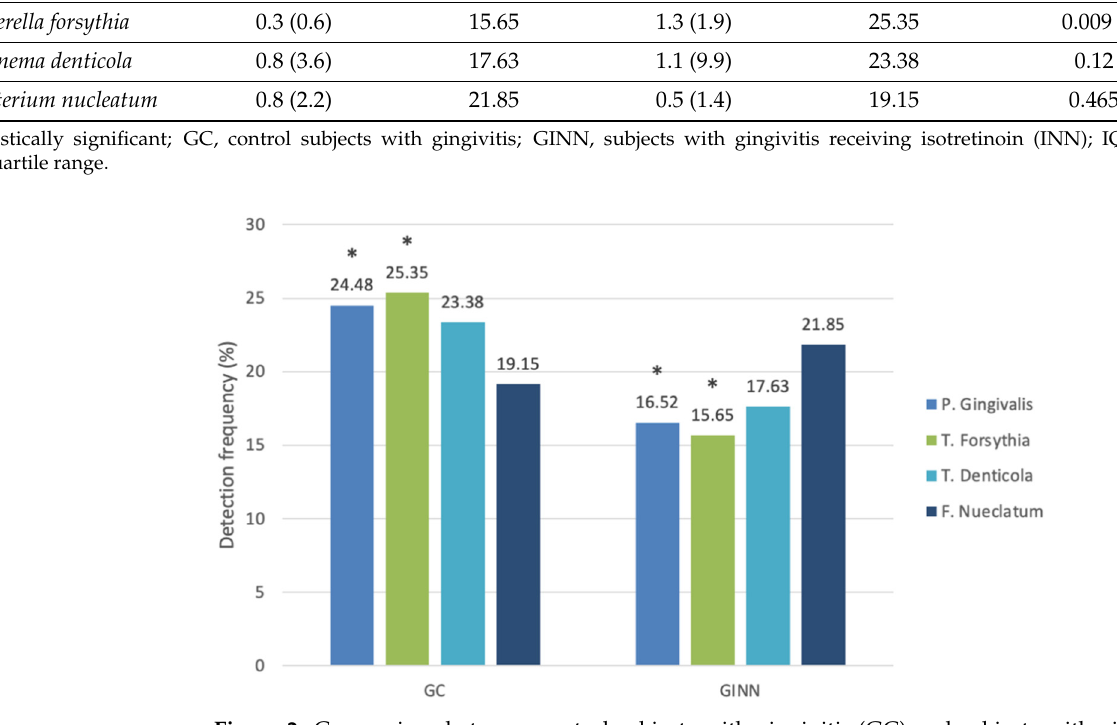
Figure 2. Comparison between control subjects with gingivitis (GC) and subjects with gingivitis receiving isotretinoin (INN) (GINN) in the detection of bacterial pathogens. *, statistically significant. P. gingivalis and T. forsythia levels were significantly higher in the PC group (29.68% and 29.45%, respectively) than in the PINN group. Furthermore, F. nucleatum levels in the PINN group were significantly higher (29.70%) than those in the PC group (11.30%). However, there were no significant differences in T. denticola levels between the PINN and PC groups ( p = 0.098) (Table 4 and Figure